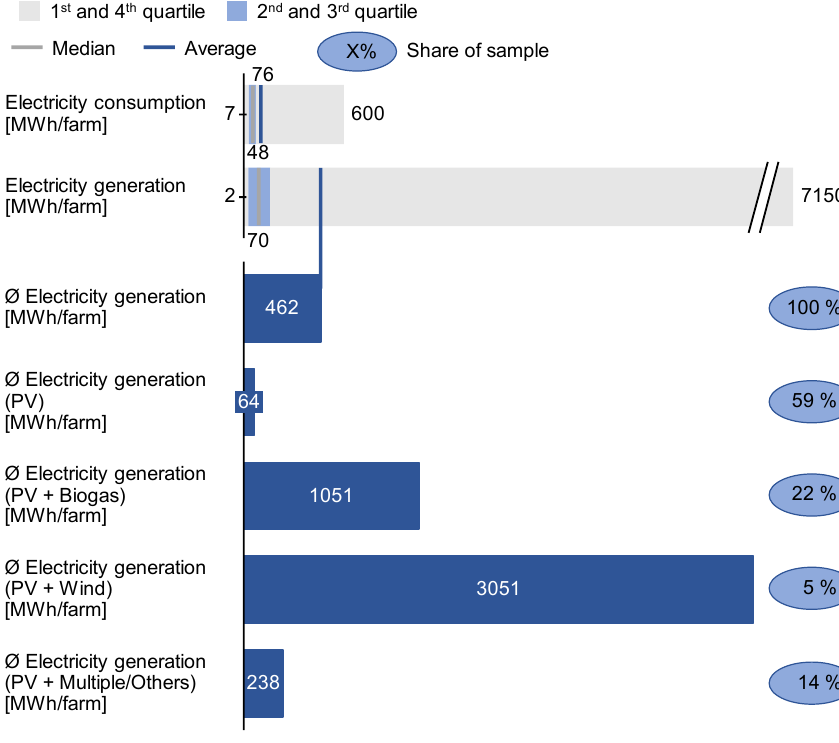
Figure 2. Electricity consumption and generation of the sample farms in 2021.